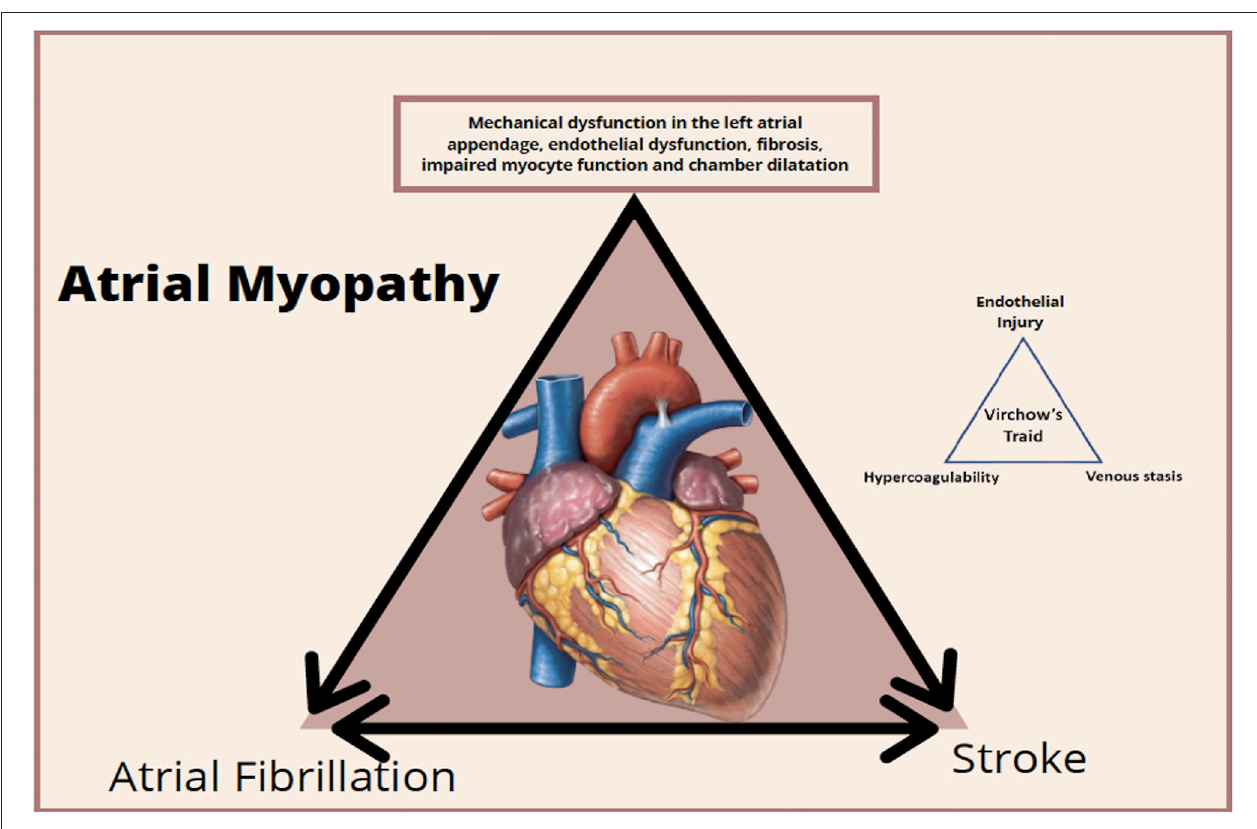
FIGURE 3 | Clinical stages and prothrombotic status of atrial